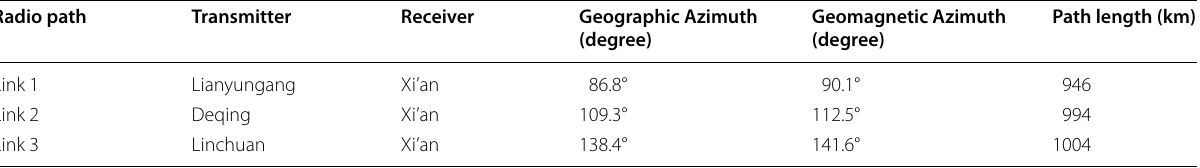
Table 1 Detail of the radio links used in the investigation Radio